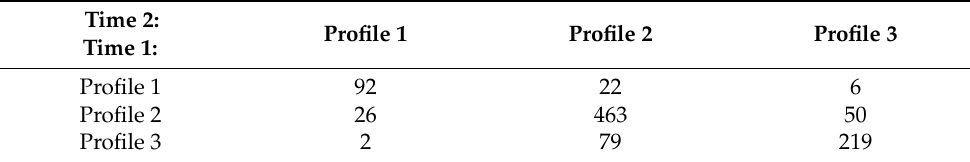
Table A5. Final counts for each profile transition